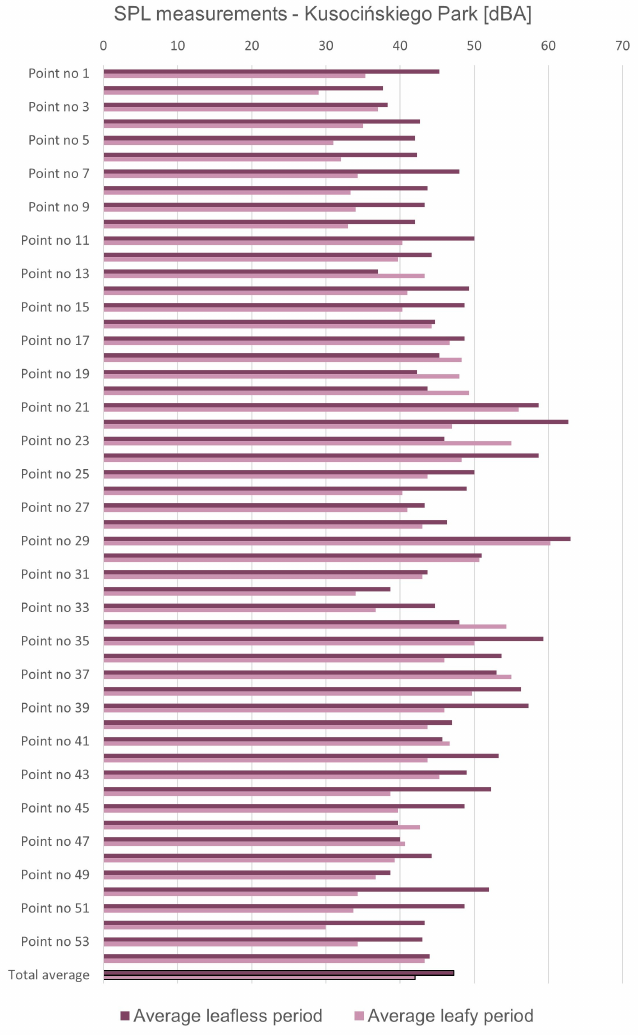
Figure 10. SPL measurements dBA—Kusoci ń skiego Park.